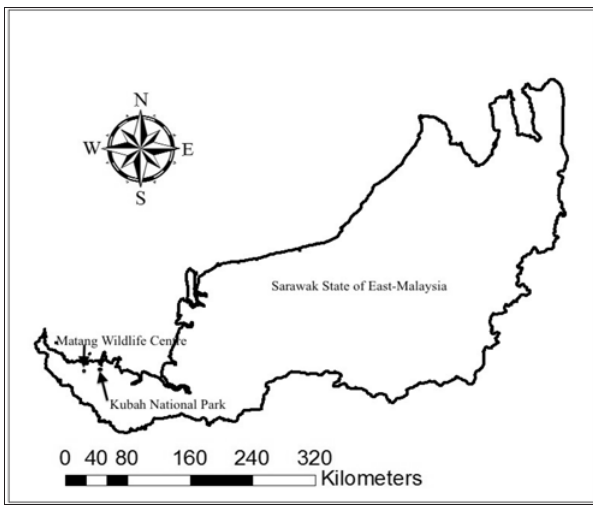
Figure-1: Location of research area in the Sarawak state of East-Malaysia Table 1:- MAT results obtained from sera of 12 primates in